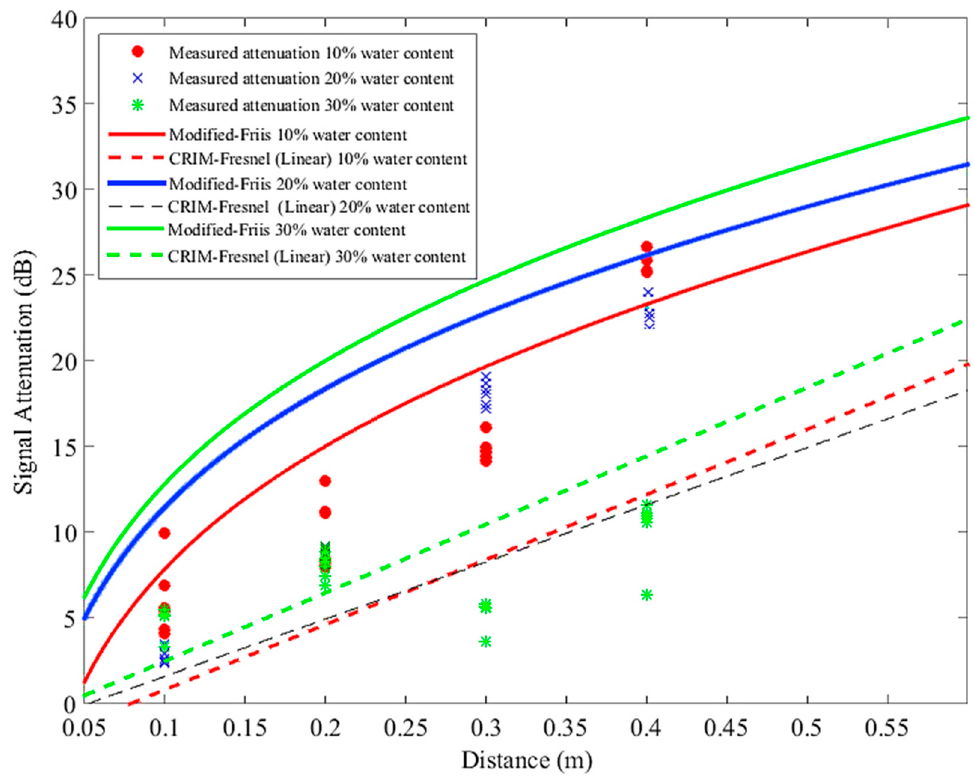
Figure 6. Effect of gravimetric water content (GWC) on prediction accuracy of RF transmission models for the 50% Clay and 50% Sand sample.